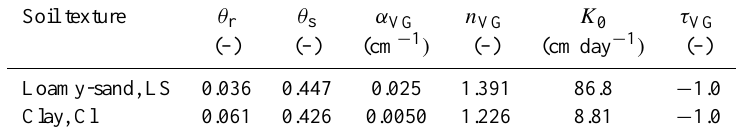
Table 1. Parameters of the van Genuchten-Mualem soil hydraulic relations for the two differently-textured soils used in this study.